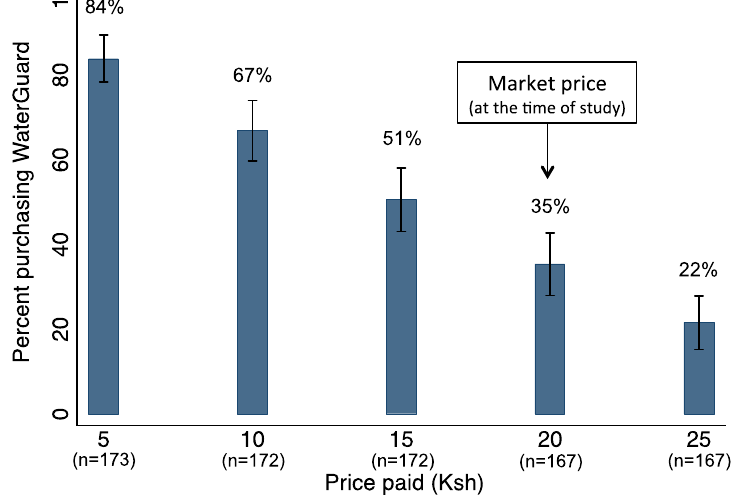
Figure 2. Percentage of respondents purchasing WaterGuard at the offered prices.